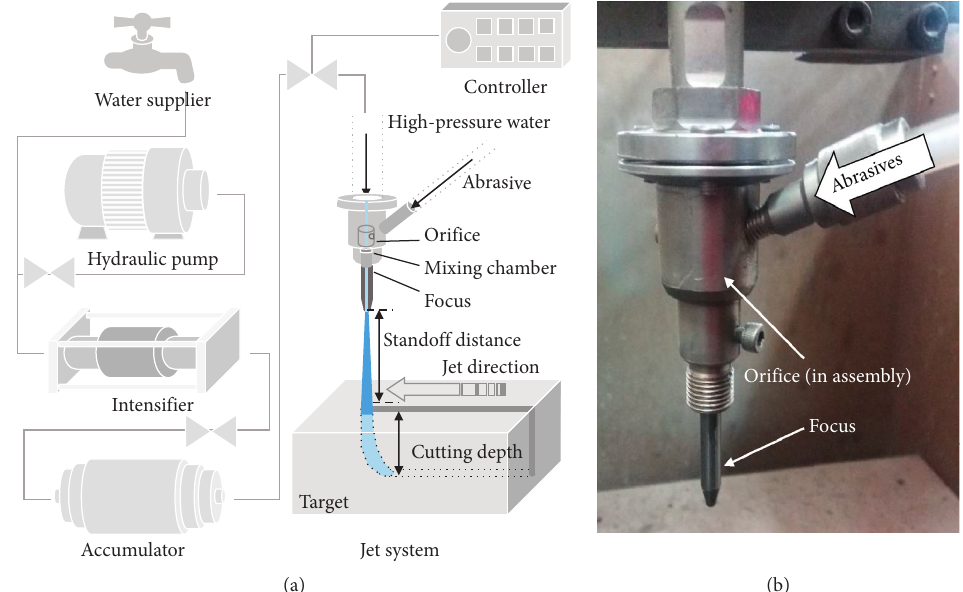
Figure 3: Experimental setup for the abrasive waterjet rock cutting: (a) rock-cutting test setup; (b) cutting head assembly.